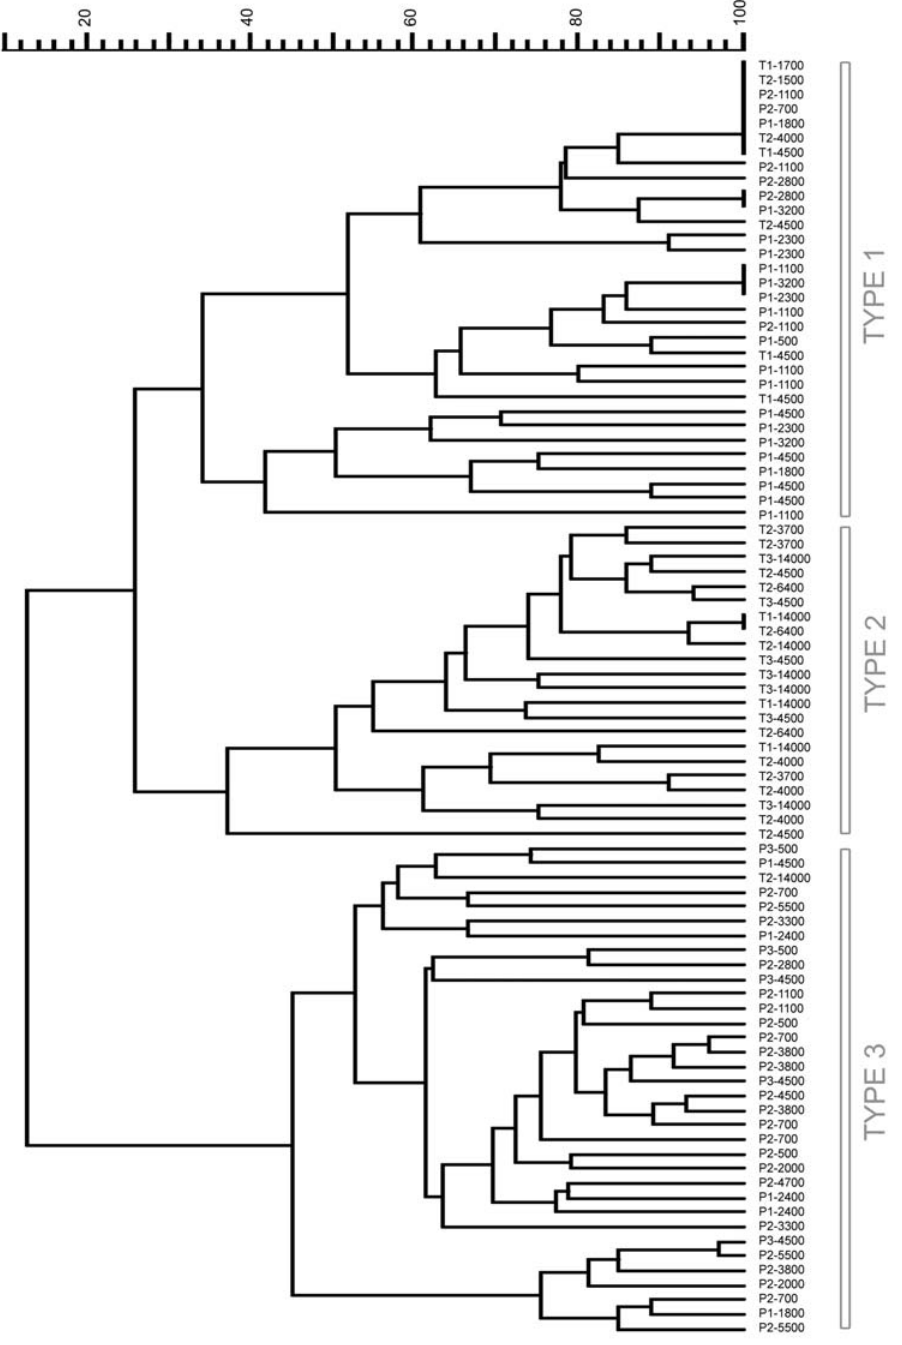
Figure 7. Extended dendrogram of the DLN histopathological profiles. Each label indicates (in order): Infecting species (P for Y. pestis , T for Y. pseudotuberculosis ), time post-injection (in days), amount of injected cfu. Top scale=% similarity. As compared to Figure 5, an extended range of infective-loads was used, and hence more DLNs were included in the analysis (see the Result section). The seven last profiles in the dendrogram correspond to completely destroyed lymph